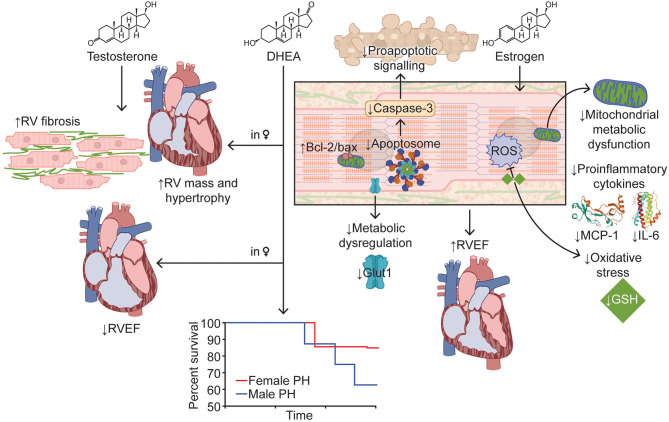
Effects of Sex Hormones on Right Ventricular Function in Pulmonary Hypertension. Estrogen improves RV function in PH via modulation of apoptosis, enhancement of mitochondrial function, and reduction in inflammation and oxidative stress. Testosterone increases RV mass, hypertrophy, and fibrosis, which results in decreased RV function. Higher DHEA levels in women are associated with lower RV ejection fraction and greater RV mass. Survival curve adapted from Rafikova et al. (2015). Images for MCP-1 and IL-6 adapted from Lubkowski et al. (1997) and Somers et al. (1997), respectively. Bcl-2/bax, B-cell lymphoma 2/bcl-2-associated X; DHEA, dehydroepiandrosterone; Glut1, glucose transporter 1; GSH, glutathione; IL-6, interleukin-6; MCP-1, monocyte chemoattractant protein-1; ROS, reactive oxygen species; RV, right ventricle/ventricular; RVEF, right ventricular ejection fraction.